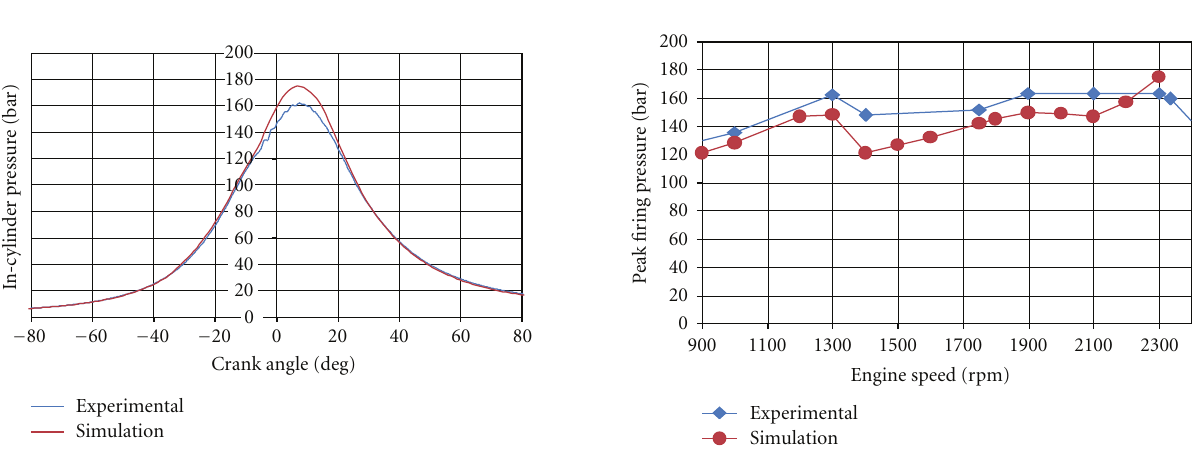
Figure 5: Comparison of experimental and simulated values of normalized specific fuel consumption.